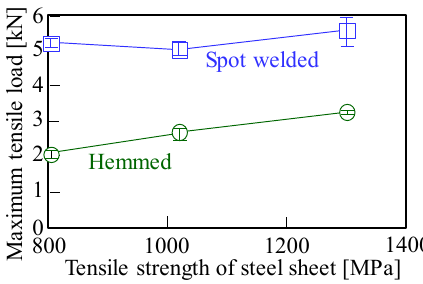
Figure 16. Maximum load in tensile test.